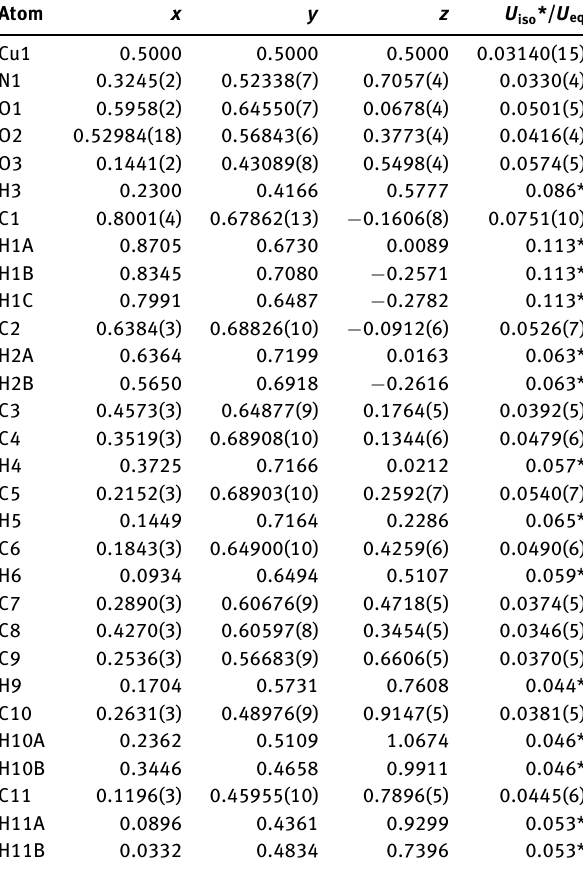
Table 2: Fractional atomic coordinates and isotropic or equivalent isotropic displacement parameters (Å 2